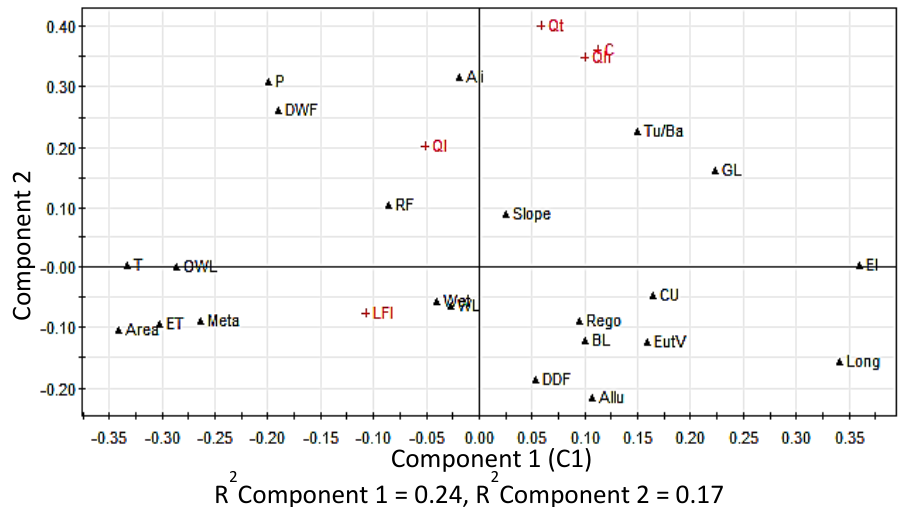
Figure 2. PCA plot of the first two components for the hydrological and watershed variables. The hydrological variables are indicated with cross signs (+) and the watershed variables with filled triangles ( N ). Codes of the variables represent; P – rainfall (mmyr − 1 ), T – temperature ( ◦ Cday − 1 ), ET – evapotranspiration (mmday − 1 ), El – elevation (m), slope – average watershed slope (%), Tu/Ba – tuffs and basalts, Meta – metamorphic rock, Allu – Alluvial, GL – grazing land, CU – cultivated land, OWL – open woodland, DWF – dense wet forest, DDF – dense dry forest, WL – woodland, BL – (degraded) bush land, RF – riverine forest, Rego – regosols, Ali – ali sols, EutV – Eutric Vertisols, Wet – Wetland, Area – watershed area (km 2 ) , Long – Longitude (degree-decimal).